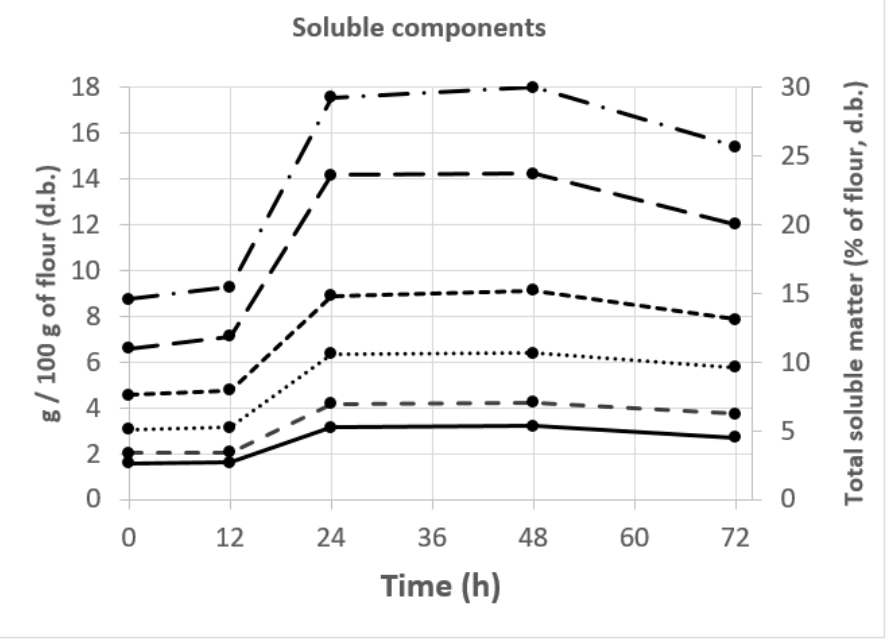
Figure 2. Changes in soluble components in quinoa flours, along the germination